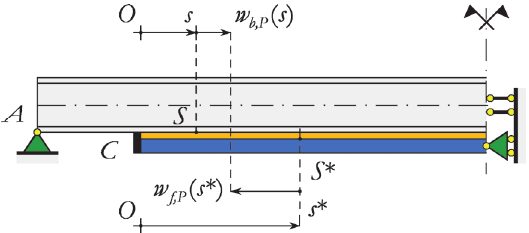
Figure 5: Displacements of beam and laminate at the end of the pre-stressing